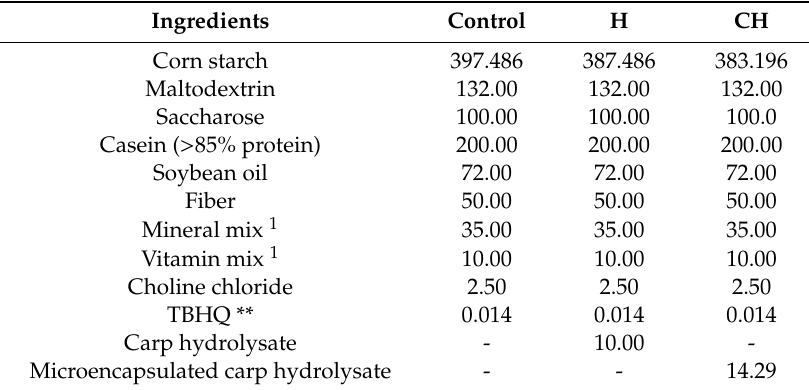
Table 1. Compositions of experimental diets (g /